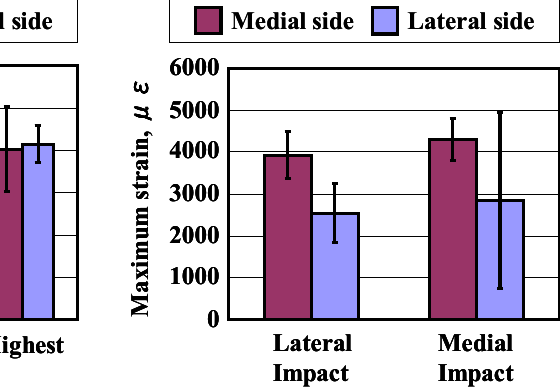
Fig. 3 The maximum strains measured in the femur at each height. The left bars represent the values for the medial side of the femur. The right bars represent the values for the lateral side of the femur.